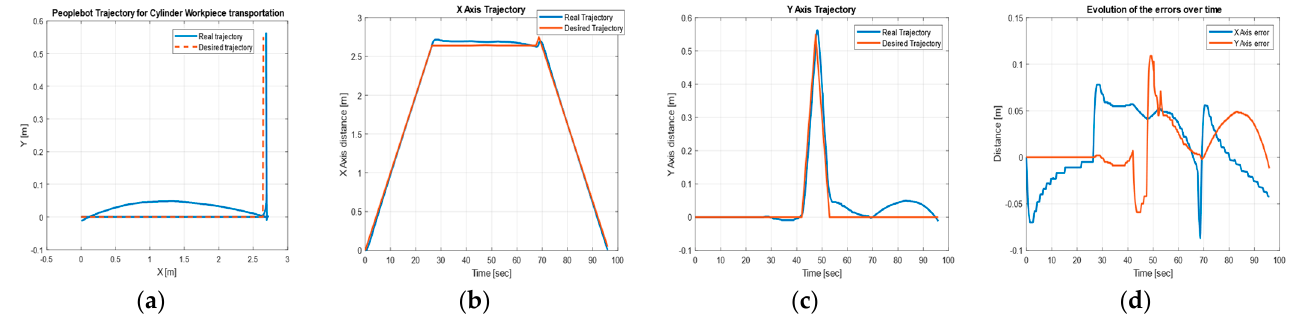
Figure 24. CAS’s DT-TTSMC for cylinder recovery: ( a ) desired and real trajectory; ( b ) along the X axis; ( c ) along Y axis; ( d ) errors.